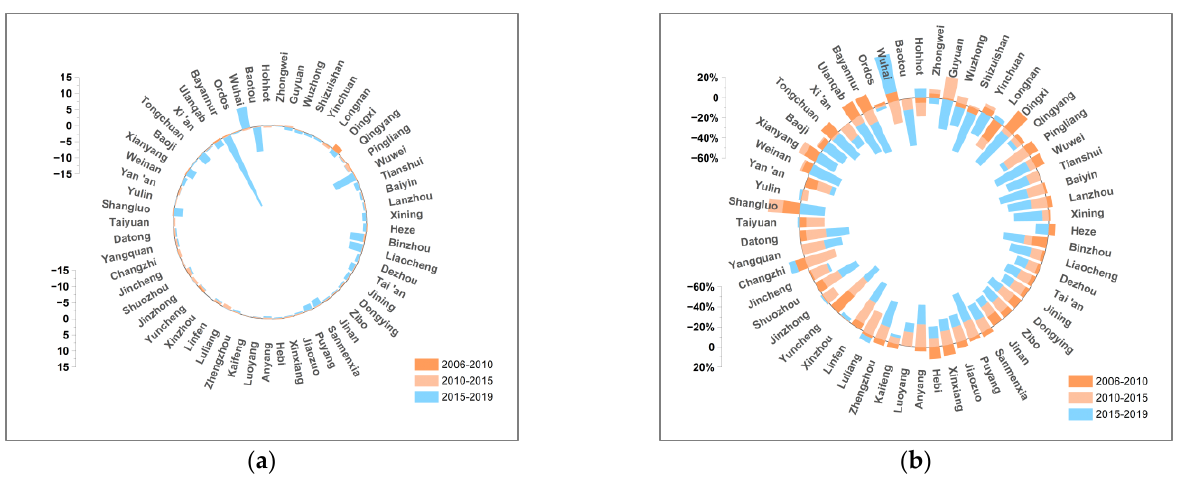
Figure 9. Contribution and contribution rate of power-intensity factor. ( a ) Contribution of power- intensity factor. ( b ) Contribution rate of power-intensity factor.